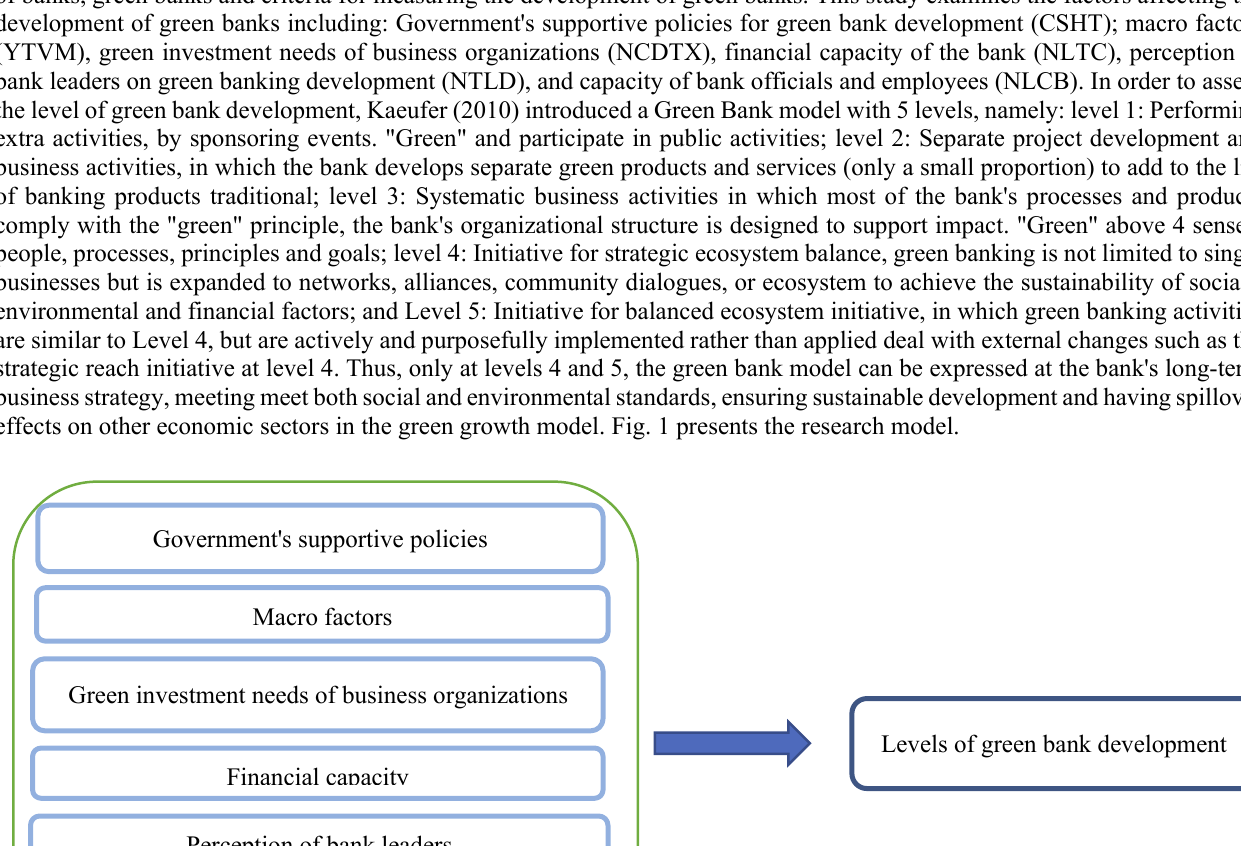
Levels of green bank